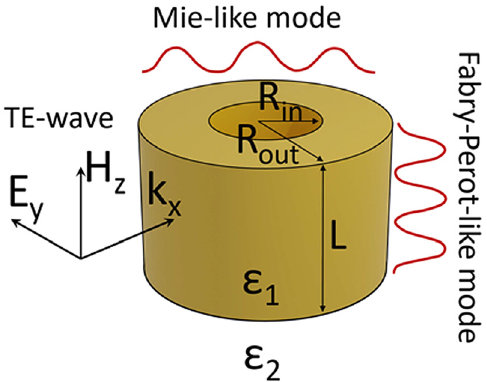
Figure 1: TE- and TM-polarized waves incident on a dielectric ring resonator with permittivity 𝜖 R out , and thickness L . The ring is placed in the vacuum, 𝜖 2 =